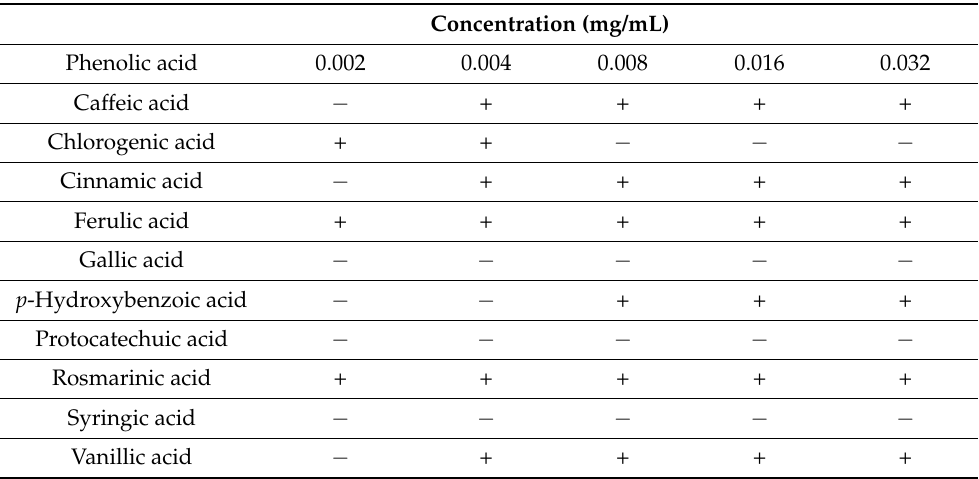
Table 5. The protective effect of phenolic acids towards H 2 O 2 + UV-induced supercoiled circular DNA